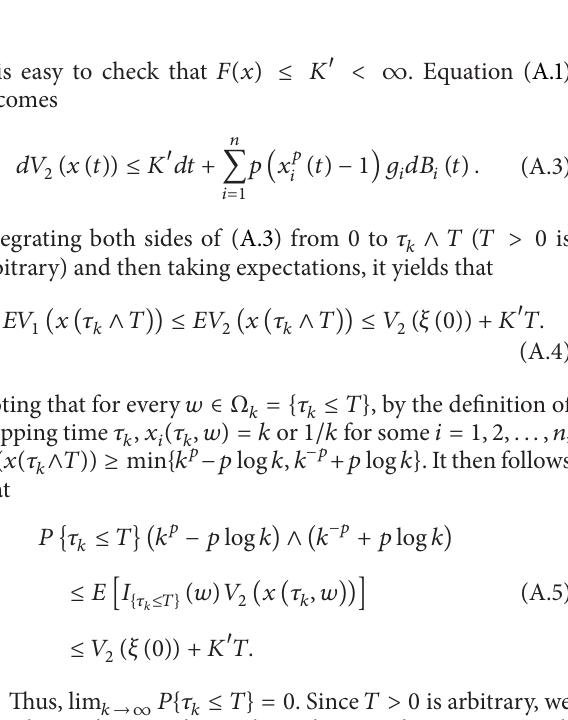
Figure 3: Each parameter of model (33) is fluctuated by white noise.